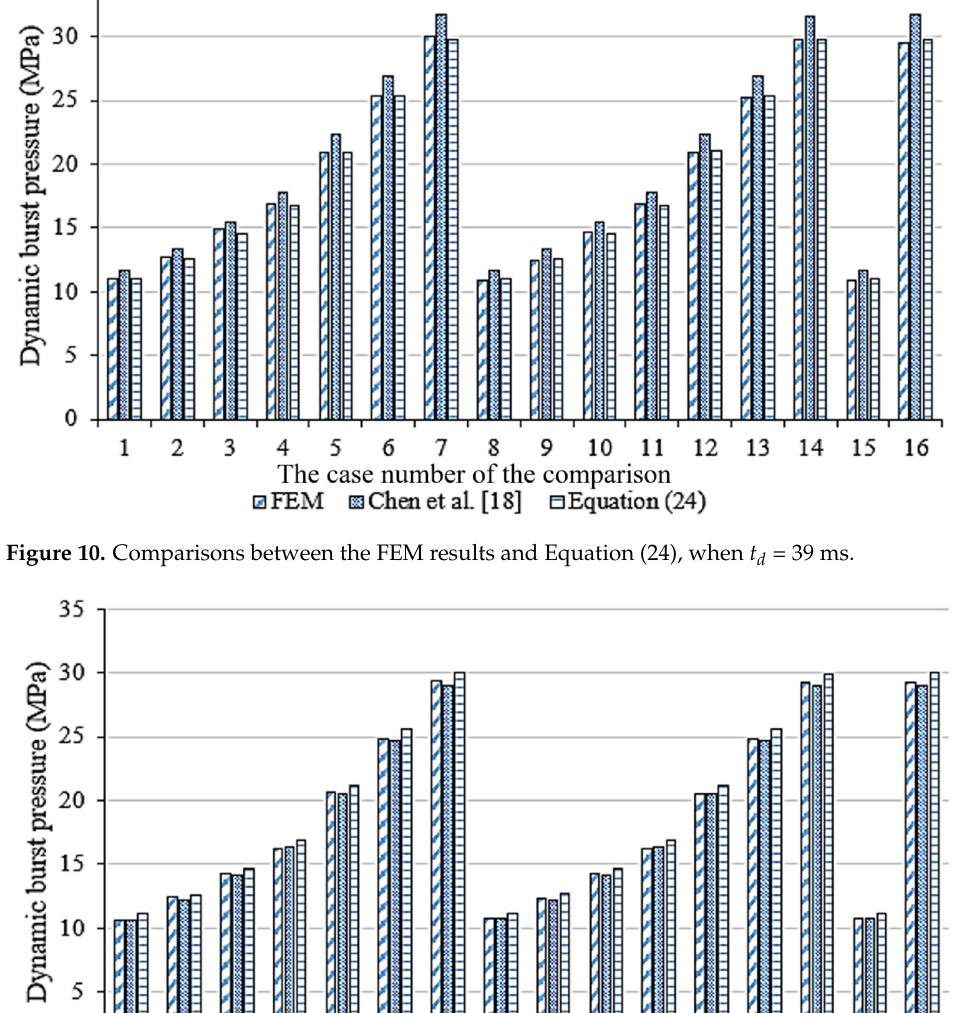
Figure 9. Comparisons between the FEM results and Equation (24), when t d = 3.9 ms.